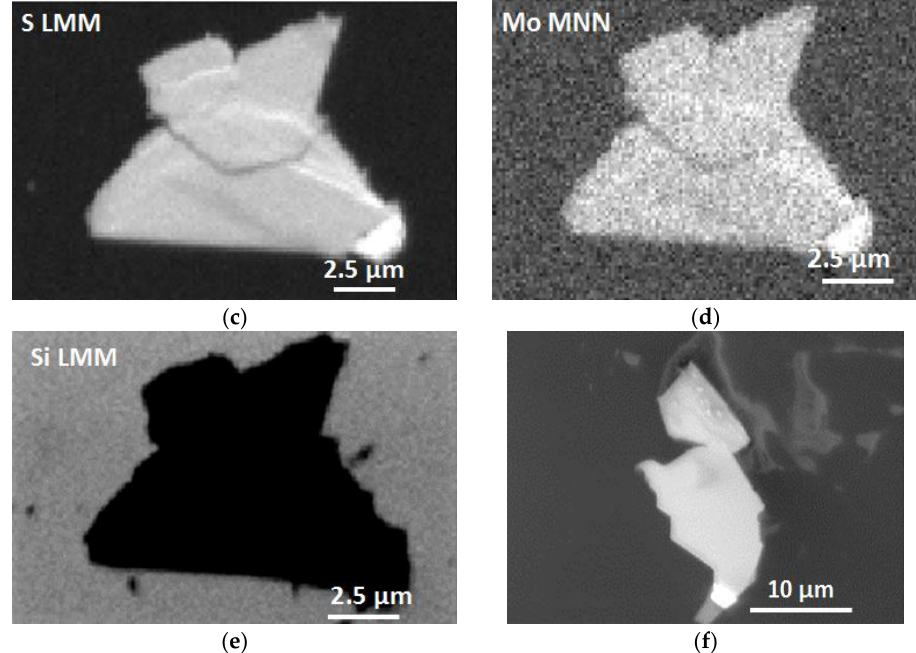
Figure 2. Scanning electron microscopy (SEM) images of the examined surfaces of Mo disulfide flakes exfoliated on silicon substrates with increasing S/Mo AC ratio: ( a ) S/Mo = 1.80; ( b ) S/Mo = 1.84; ( c – e ): Distribution images of elements for the Mo disulfide flake from ( b ): S (LMM) in ( c ), Mo (MNN) in ( d ) and Si (LMM) in ( e ) on the flake surface suggesting chemical homogeneity of considered surfaces; ( f ) another flake with S/Mo = 1.88.